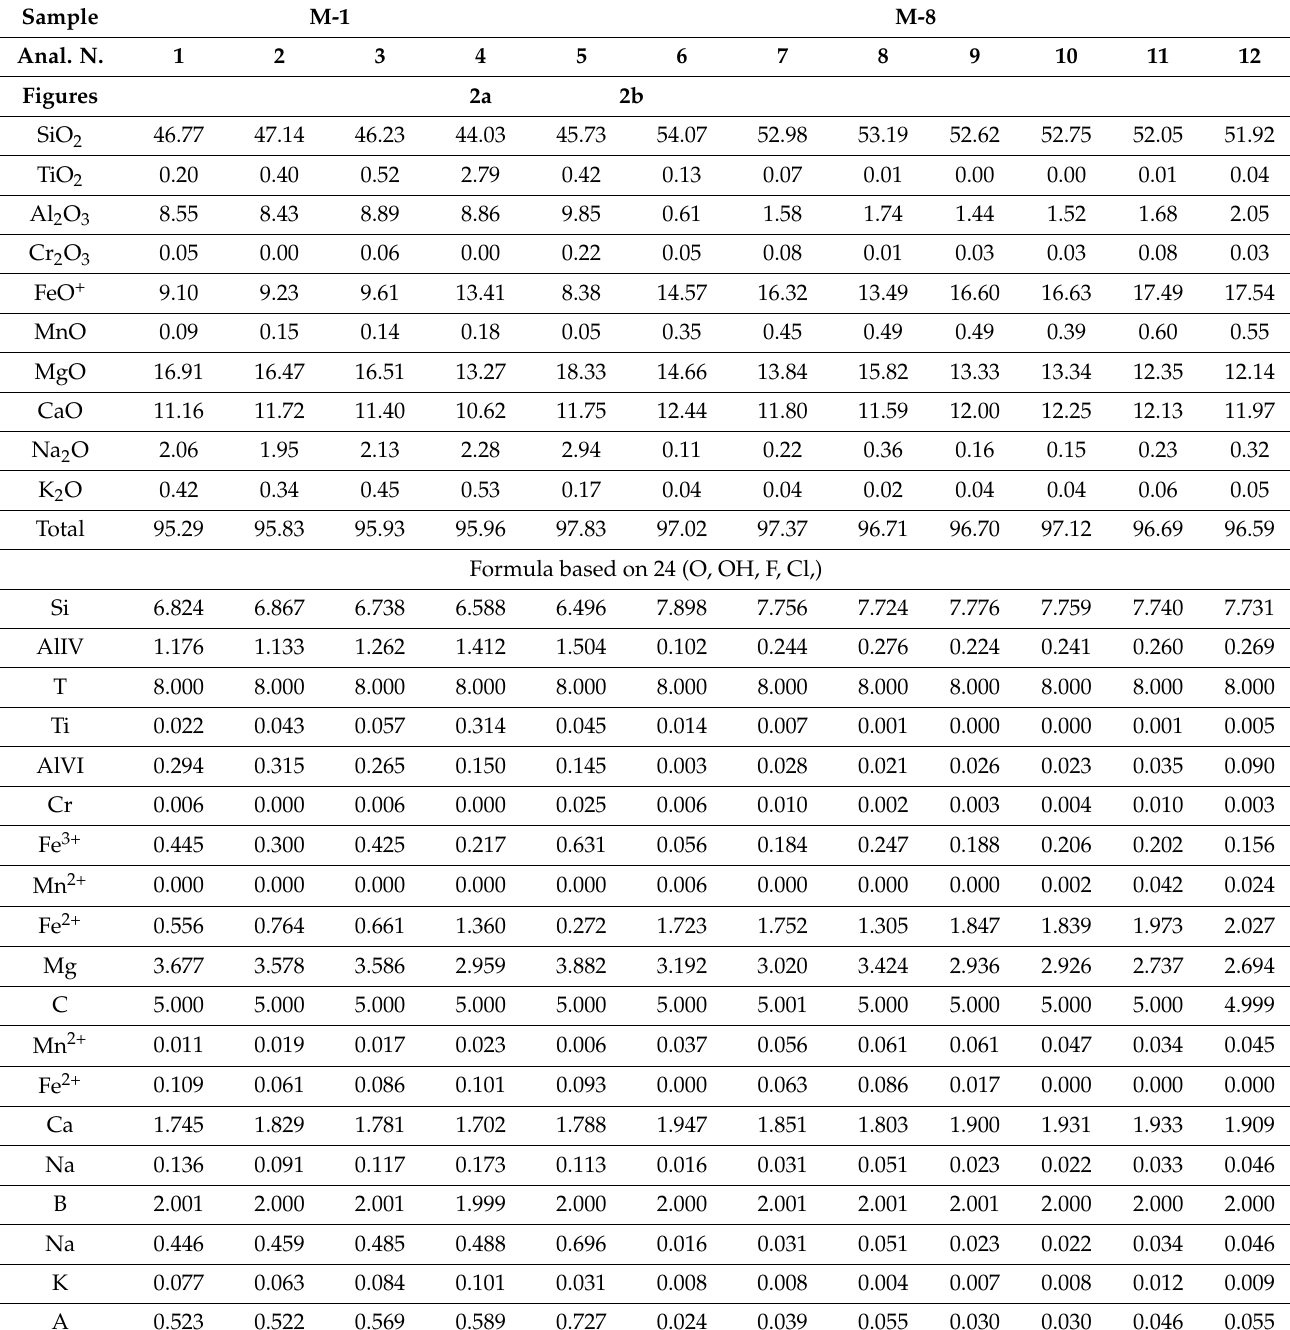
Table 3. Selected analyses of